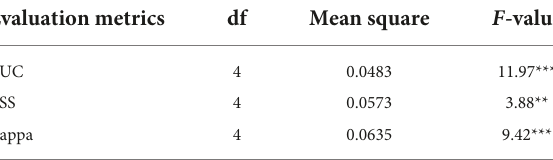
TABLE 3 Analysis of variance of AUC, TSS, and Kappa determined using five species distribution models (SDMs). Evaluation